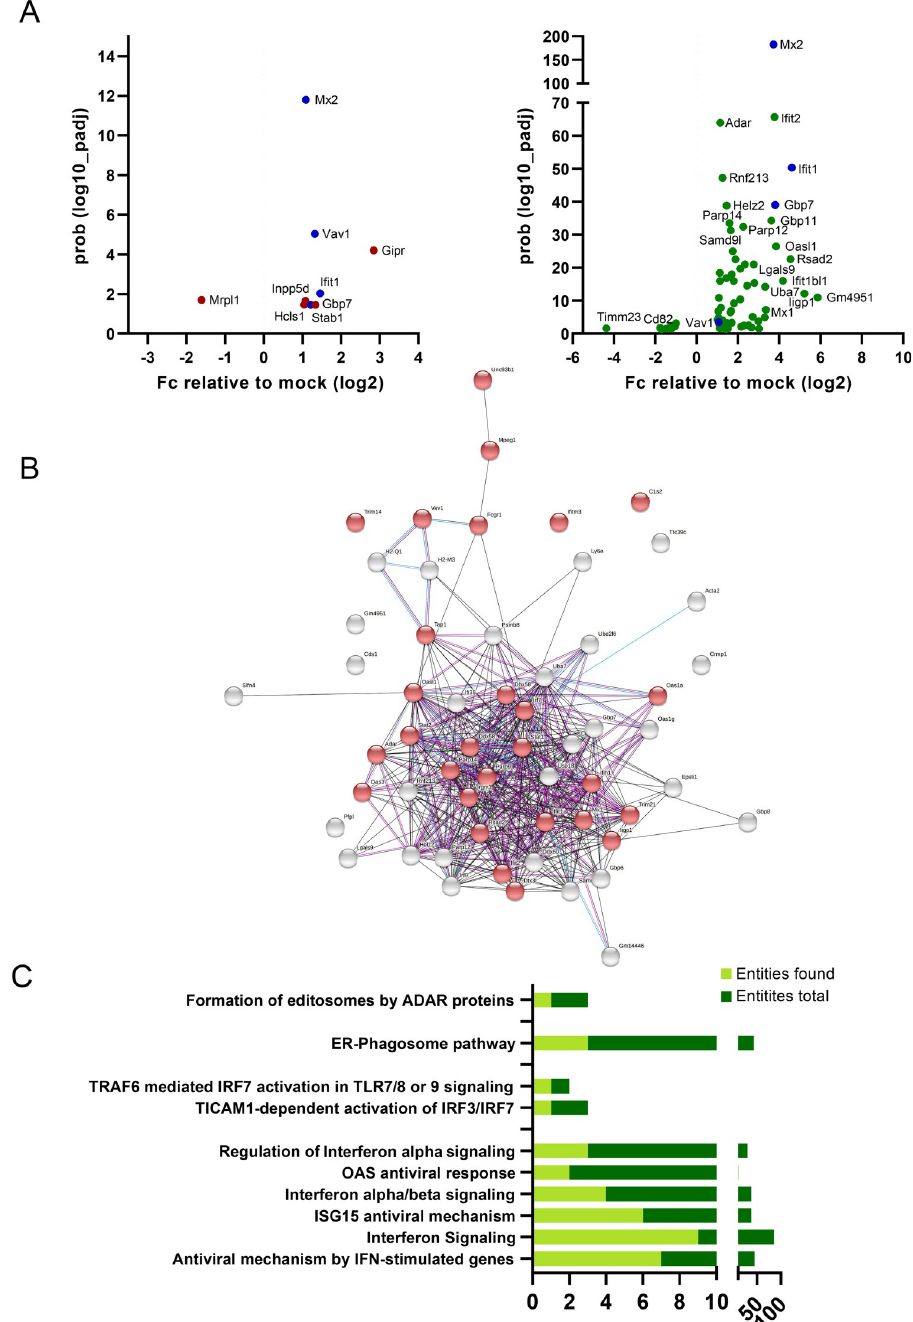
Fig 9. Transcriptome analysis of MyglaSWRecB bank vole cells infected with PUUV and PHV. Graphs in (A) represents the upregulated genes in MyglaSWRecB cells infected with PUUV (left panel) and PHV (right panel), as compared to non-infected (NI) cells, which were identified by RNA-Seq using the Mus musculus reference genome, GRCm38/mm10. Graphs were generated using GraphPad Prism software by plotting the -log10 of the adjusted p-value against the log2 of the fold change in gene expression. Genes colored in blue were up regulated under both viral conditions, while PUUV- and PHV-specifically induced genes are shown in orange and green, respectively. In (B) M . musculus transcriptome data for PHV-infected bank vole cells were analyzed using the on line-software STRING. The up-regulated genes are represented as an interaction network, with the nodes involved in the immune response colored in red, according to the GO terminology. In (C), the most significantly enriched pathways, compared to non- infected cells, are listed based on Reactome classification. The number of genes identified in RNA samples of